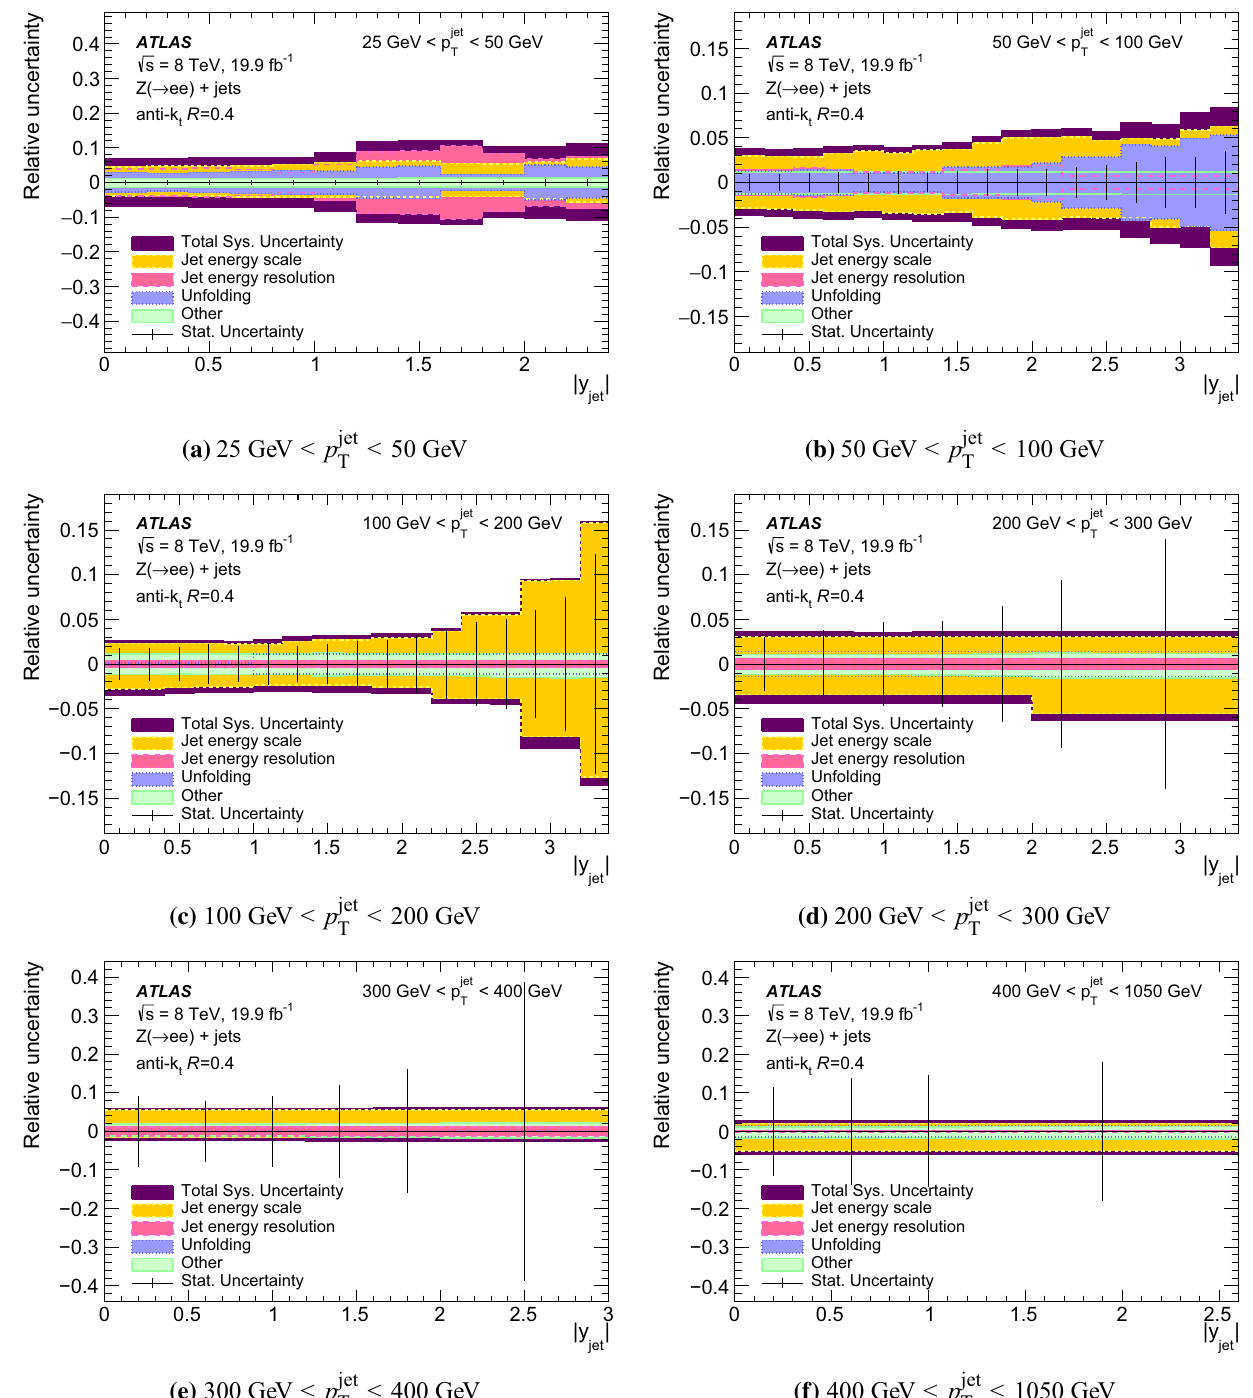
Fig. 2 Experimental uncertainties in the measured double-differential Z + jets production cross-section as a function of | y jet | in p jet The jet energy scale, jet energy resolution, unfolding, ‘other’ and total systematic uncertainties are shown with different colours overlaid. The jet energy scale uncertainty is the sum in quadrature of the jet energy scale uncertainty components. The unfolding uncertainty is the sum